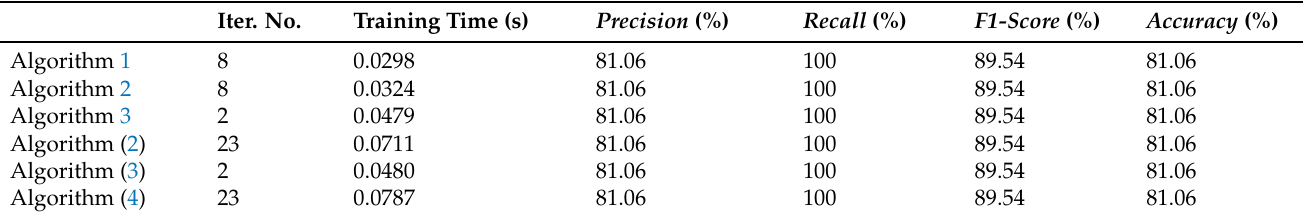
Table 5. The performance of our Algorithm 3 compared with the other existing algorithms. Iter. No.